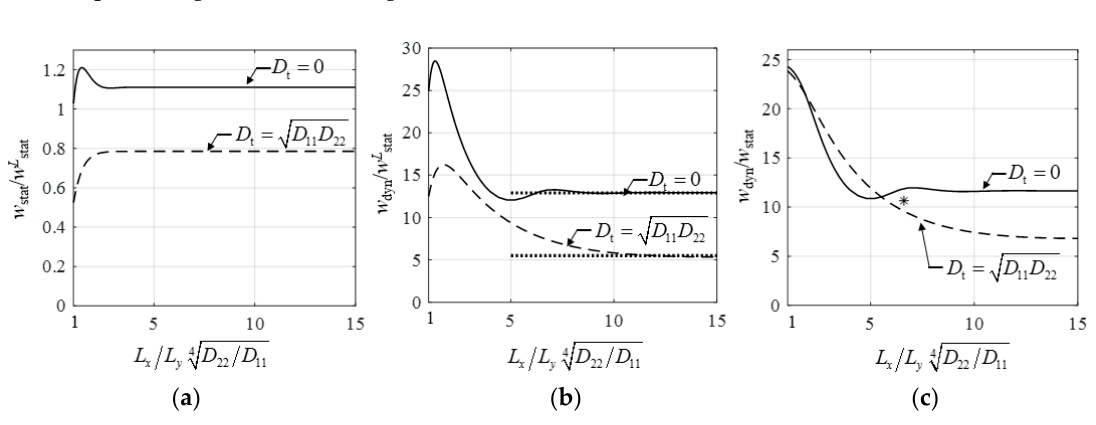
Figure 9. Phase angle of plates with finite length subjected to a trigonometrical line load 4